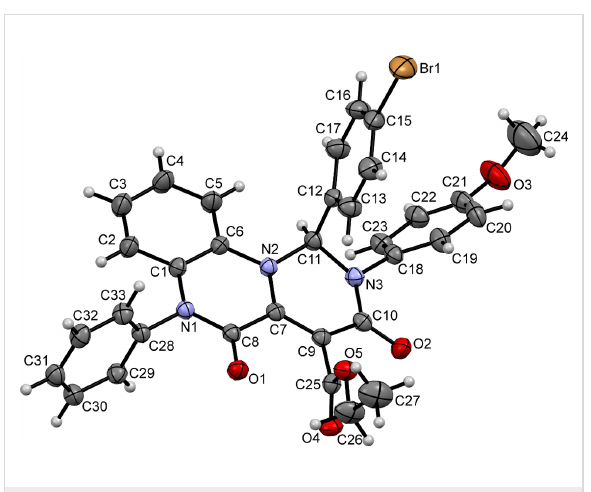
Figure 7: ORTEP drawing of compound 3j (CCDC 1834012) showing thermal ellipsoids at the 30% probability